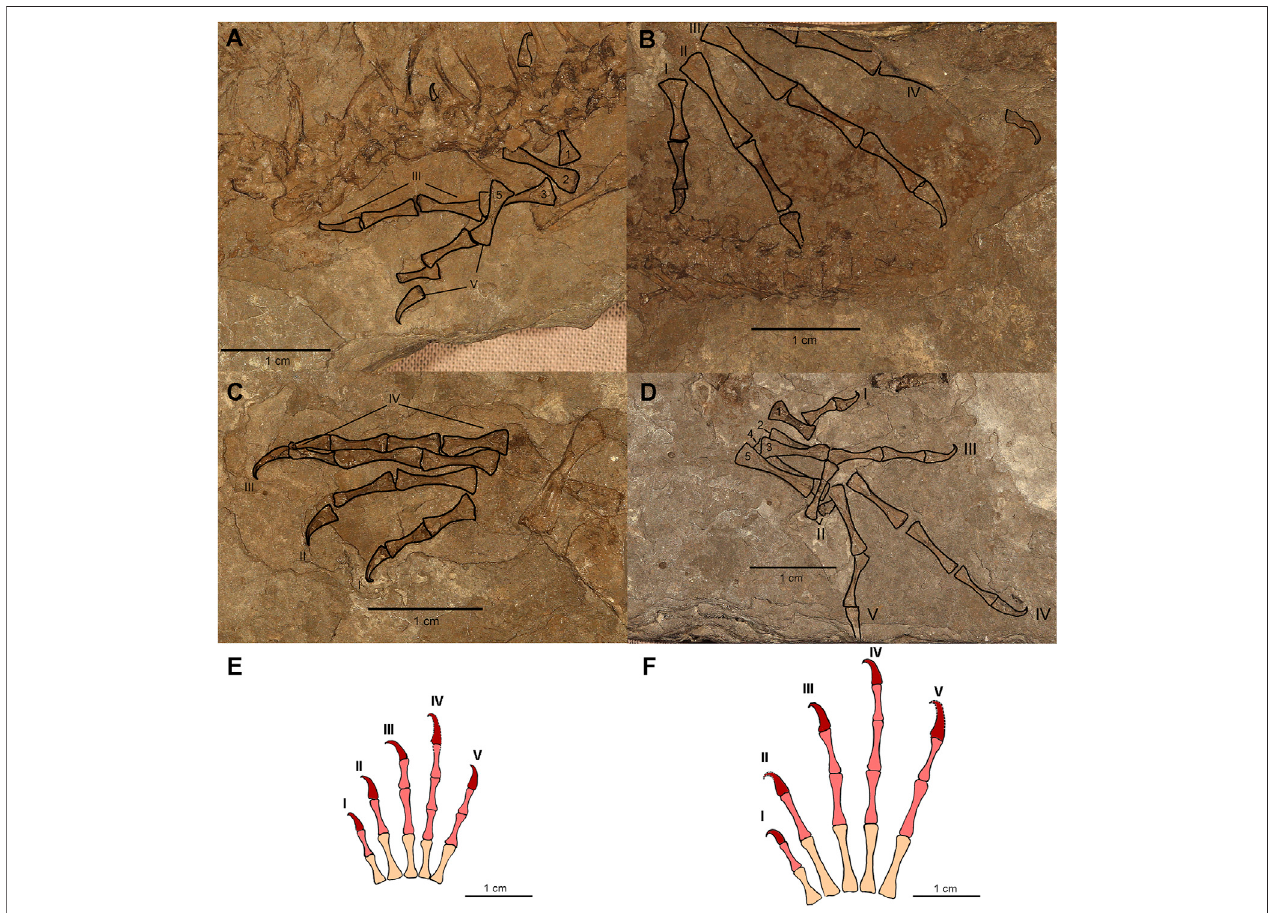
FIGURE 2 | Limbs of CM 81532. (A) Photograph of the left forelimb with manual elements outlined and labeled. (B) Photograph of the left hindlimb with pedal elementsoutlinedand labeled. (C) Photographoftheright forelimbwithmanual elements outlinedand labeled. (D) Photographofthelefthindlimbwithmanualelements outlined and labeled. (E) Reconstruction of the right manus. (F) Reconstruction of the right pes. Roman numerals in A – F identify digits while numbers 1 – 5 indicate metatarsal and metacarpal position. Phalangeal reconstructions based on the anatomy of AMNH FARB 6940 and CM 81532. Colors on reconstructions indicate: metatarsals/metacarpals (cid:1) peach, main series phalanges (cid:1) light red, terminal phalanges (cid:1) dark red.